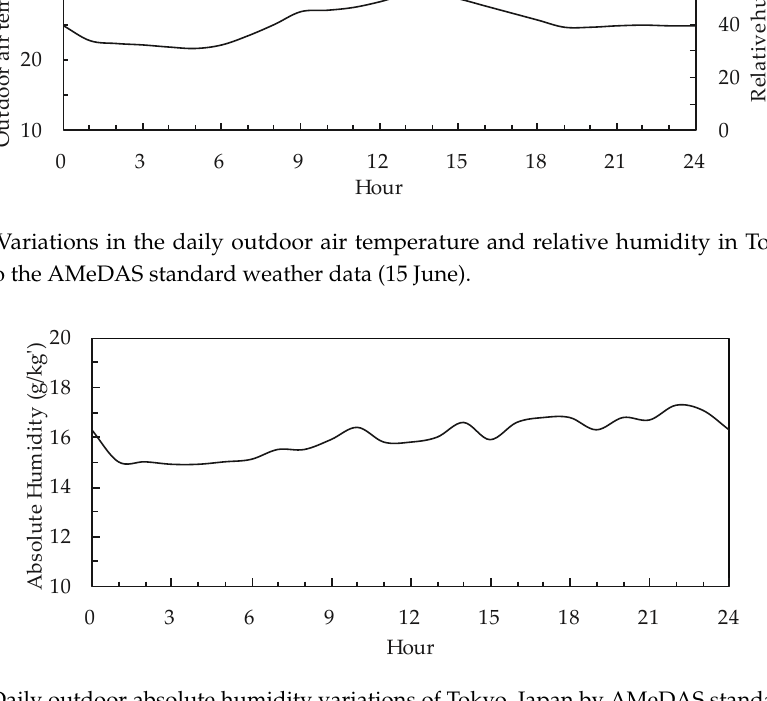
Figure 14. Daily outdoor absolute humidity variations of Tokyo, Japan by AMeDAS standard weather data (June 15).